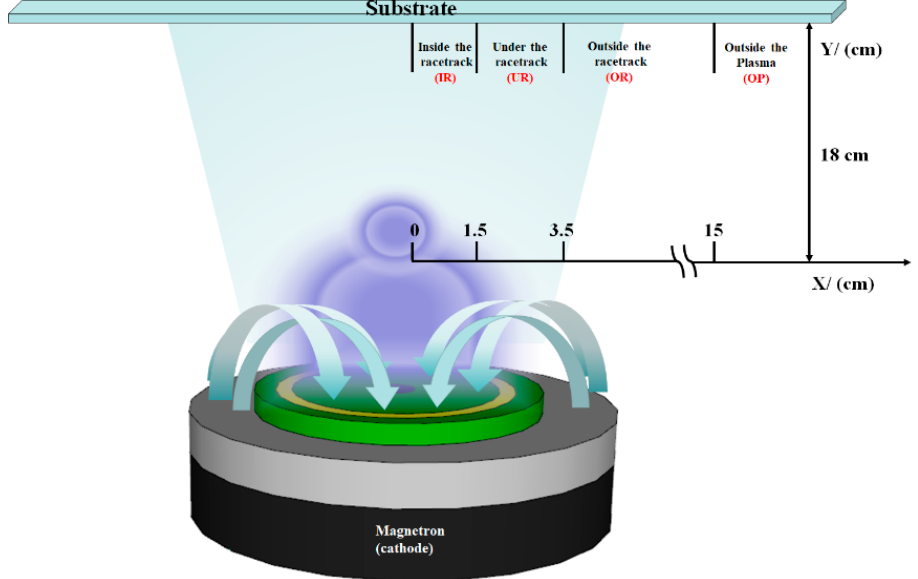
Figure 1. SLG substrates at different locations relative to target materials, divided into four regions: (1) inside the racetrack; (2) under the racetrack; (3) outside the racetrack; (4) outside the plasma.